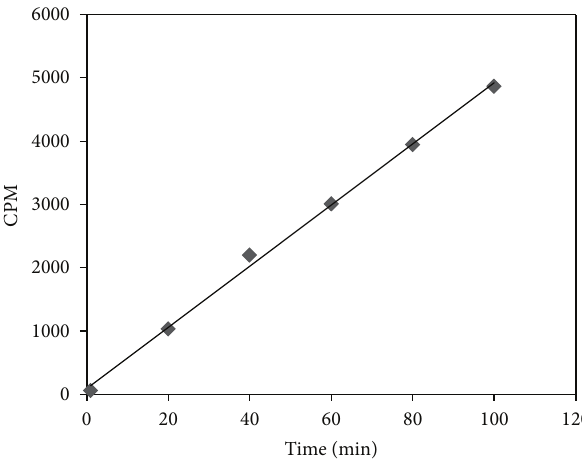
Figure 4: Exemplifying plot of the amount of radioactive water in CPM (counts per minute), having diffused across a single layer PHB film made from an emulsion template consisting of 10% of water and 2.9% (w/v) of Li 2 SO 4